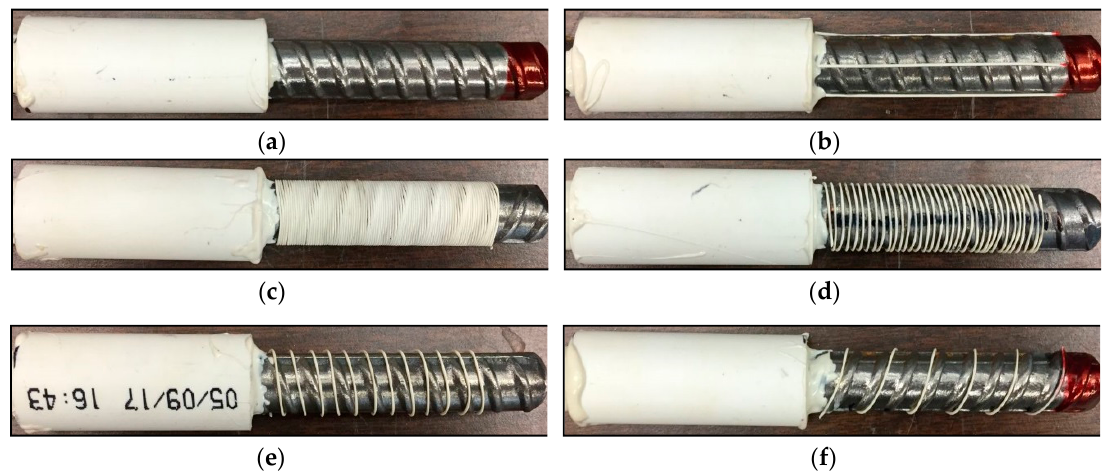
Figure 3. Photograph of steel bars in concrete cylinders for pull-out test: ( a ) Ref; ( b ) L4; ( c ) S0; ( d ) S2; ( e ) S5; ( f ) S10.